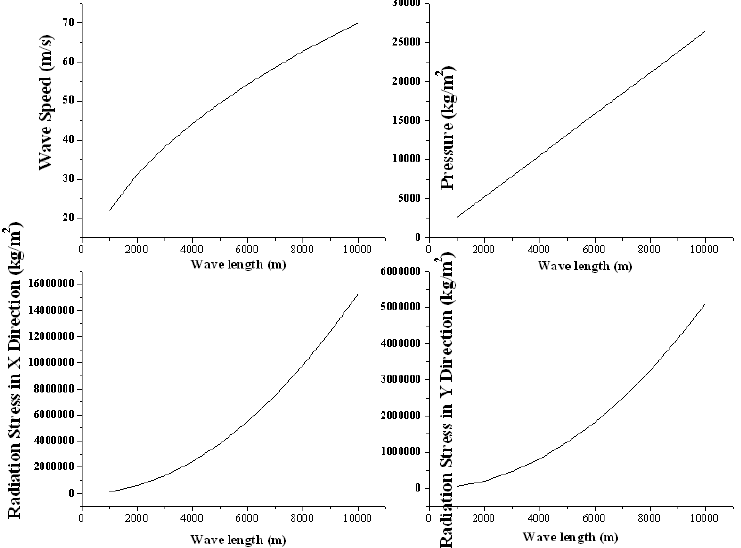
Figure 3: Mathematical characteristics of wave in shallow water.